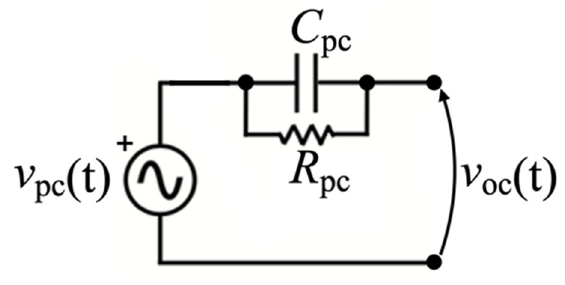
Figure 9. Thévenin equivalent model of a single PC.